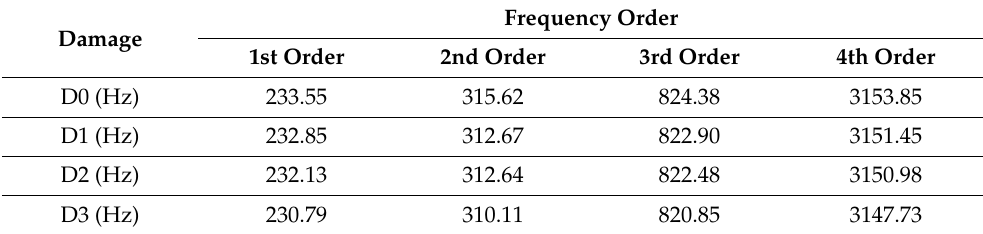
Table 2. Pipeline frequency orders.